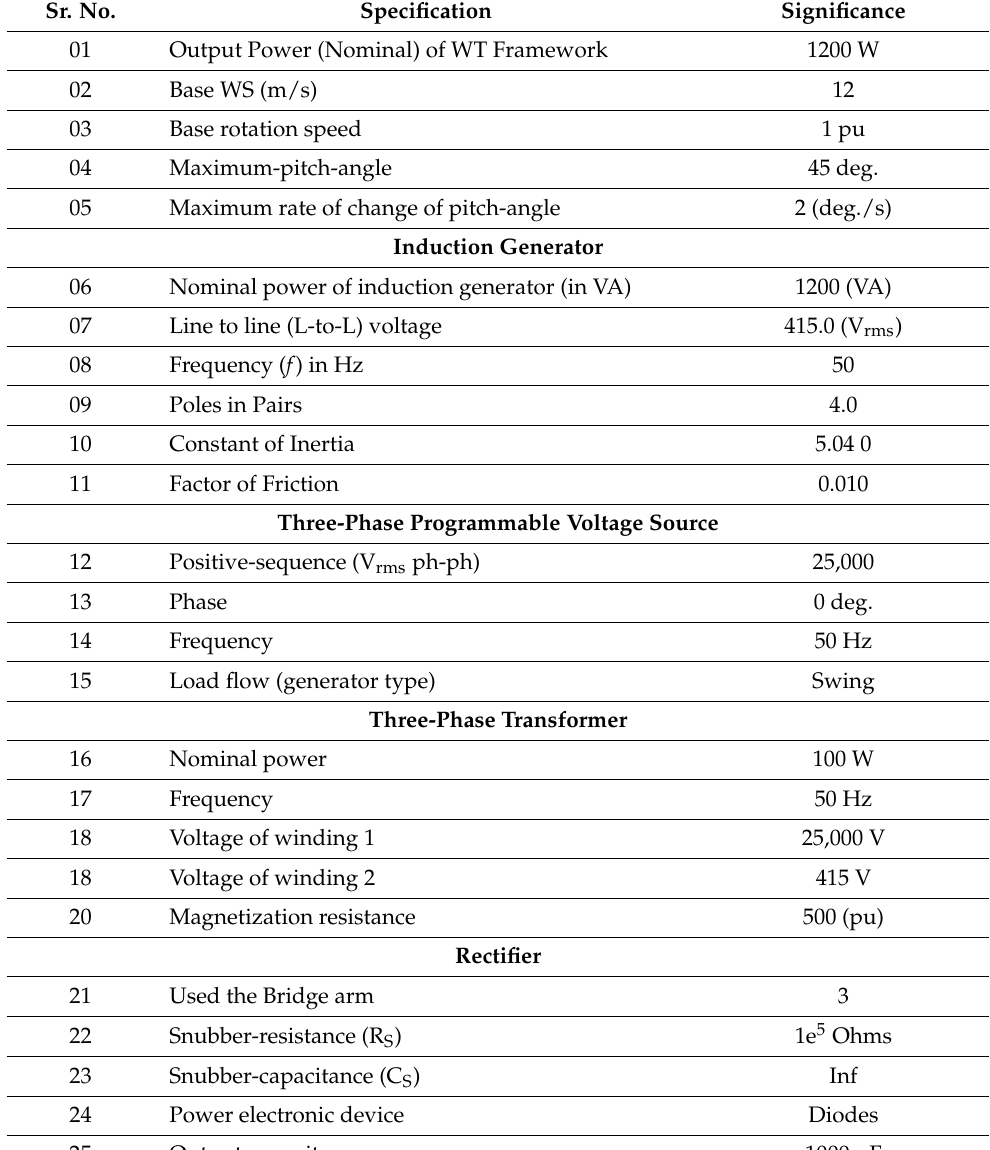
Table 3. WTIG Module Specifications.